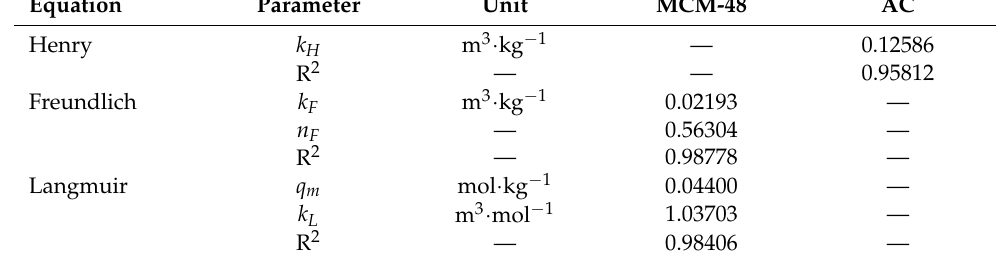
Table A15. Adsorption isotherm parameters for RuCp 2 from scCO 2 solution at 17 MPa and 333 K on different substrates [64]. Figure A15. Uptake of RuCp 2 at 17 MPa and 333 K on different substrates; experimental data taken from [64].